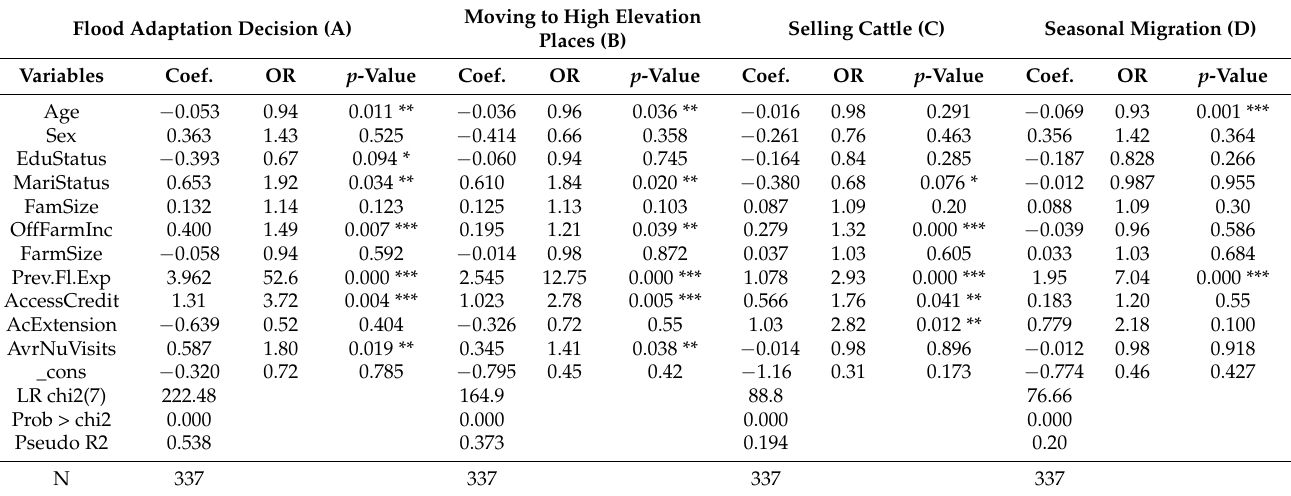
Table 6. Regression Results of the Extended PMT Model (Short-Term Coping